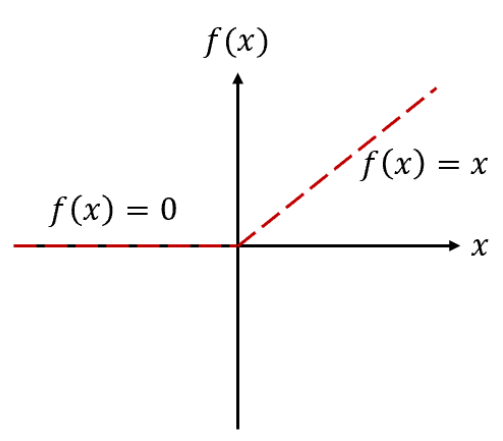
Figure 3. The activation function of neurons ( 𝑓).